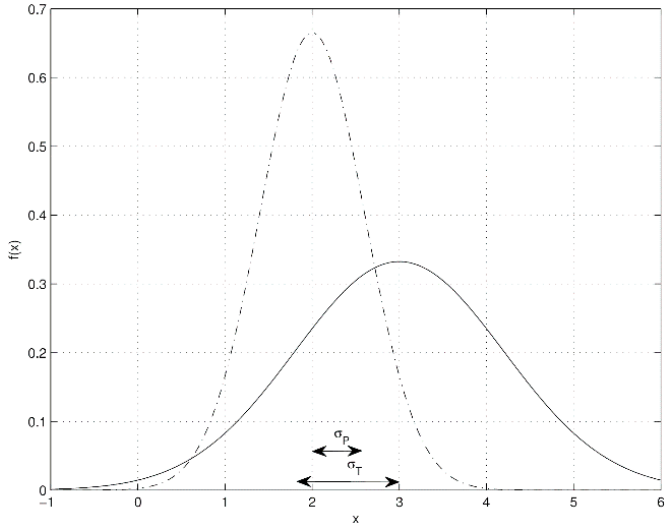
Figure 1. Example of a distribution curve when technology and pen-and-paper are qualitatively equivalent.